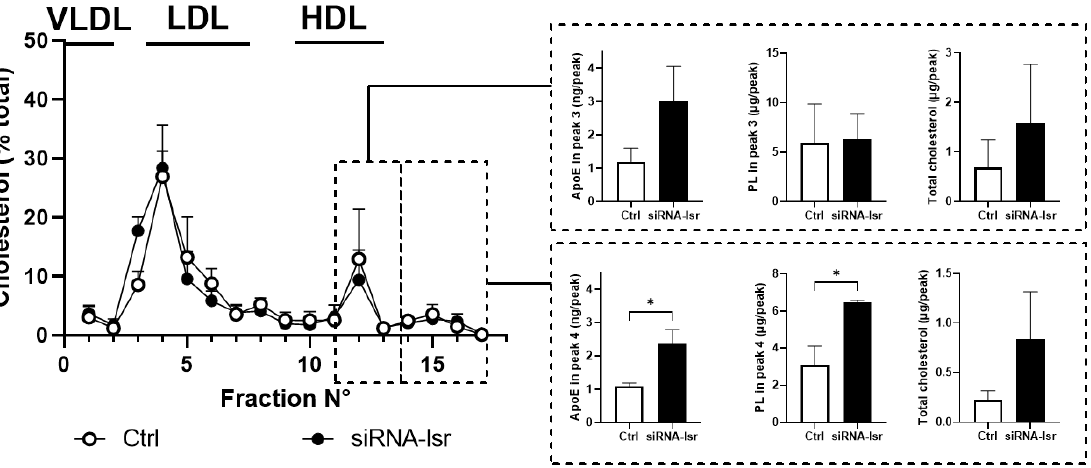
Figure 2. Effect of siRNA-mediated knockdown of lsr on lipoprotein profiles in culture media from murine astrocytes expressing human ApoE3. Cell culture media were collected from astrocytes treated with siRNA targeting lsr (siRNA- lsr ) or siRNA negative control (Ctrl) (see Figure 1). The media were pooled, concentrated, and fractionated by gel filtration chromatography as described in Materials and Methods. Fractions were analysed for total cholesterol and ApoE content. Left panel: relative cholesterol levels (% of total) in each fraction are shown (mean ± SEM, n = 3–4 per group). The fractions corresponding to elution of plasma lipoproteins, VLDL, LDL, and HDL are indicated above the chromatogram. Right panel: ApoE, phospholipid, and total cholesterol levels in pooled fractions of the corresponding peaks are indicated ( top right panel for fractions 11–13; bottom right pane for fractions 14–17; n = 3–4/group). Statistical differences are shown as: * p < 0.05.